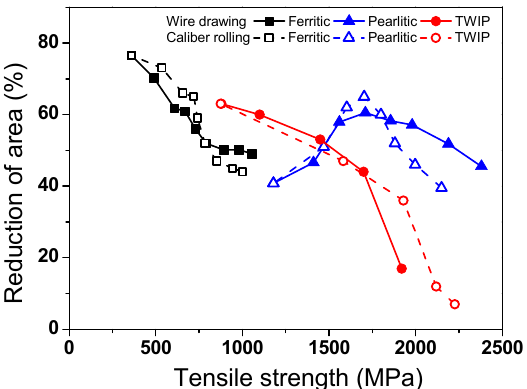
Figure 4. Comparison of the balance in strength and ductility of the three drawn and caliber-rolled steel wires.